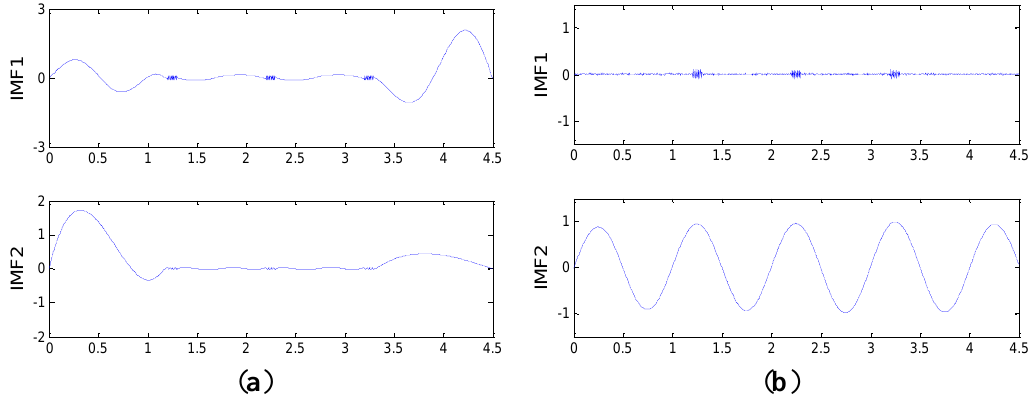
Figure 3. The decomposition result of the simulation signal: ( a ) with EMD; ( b ) with